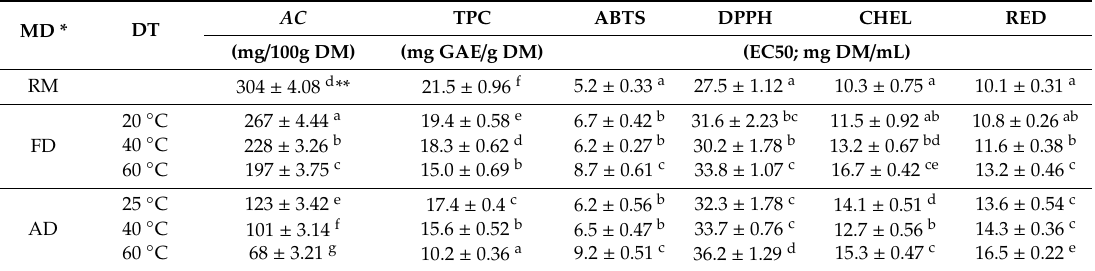
Table 7. L-ascorbic acid content, total phenolics content, and antioxidant activity of wild